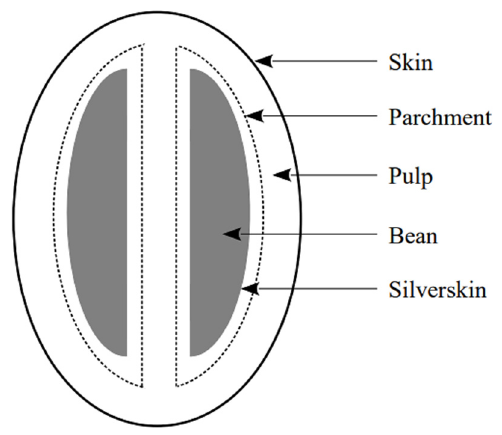
Figure 1. Schematic view of a coffee cherry. Own compilation based on literature data [34].